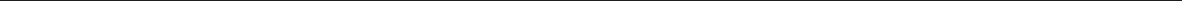
Fig. 8 Omb converts layer 1/2 into layer 3/4 T4/T5 neurons by Dac downregulation. a , b In the 3rd instar larvae ( a ), Omb (red) and Dac (blue) were initially co-expressed (arrows) in new-born R9B10-Gal4 UAS-cd8GFP (green) labeled T4/T5 neurons close to the d-IPC. In some more mature T4/T5 neurons, that were positive for Omb, Dac expression was low (arrowheads), while in others, Dac expression was high (double arrowheads) and Omb expression was absent. At 24 h after puparium formation (APF) ( b ), Dac (double arrowheads) and Omb (arrowheads) show mutually exclusive expression. c – g In controls ( c ), Dac (red, double arrowheads) was expressed in approximately 50% of T4/T5 neurons. Arrowheads indicate Dac-negative R9B10-Gal4 UAS-cd8GFP (green) labeled T4/T5 neurons. Dac was maintained in almost all T4/T5 neurons following omb knockdown ( d ), and downregulated following omb overexpression ( e ). Dac was expressed in all T4/T5 neurons in wg{KO;NRT-wg} fl ies with two lobula plate layers ( f ). Ectopic Omb was suf fi cient to downregulate Dac in these fl ies ( g ). h Quanti fi cation of all and Dac-positive T4/T5 neuron numbers following omb manipulations. The scatter plot with bars shows data points and means with ±95% con fi dence interval error bars ( n = 15 corresponding to three serial optical sections, 6- μ m apart, from fi ve samples per genotype). Unpaired, two-tailed Student ’ s t -test not assuming equal variance: P = 5.57 × 10 − 12 , P = 6.19 × 10 − 15 , P = 1.26 × 10 − 10 , P = 1.98 × 10 − 17 , P = 3.60 × 10 − 5 , P = 4.79 × 10 − 15 , P = 0.020, P = 0.017, P = 0.0015, P = 2.42 × 10 − 13 . * P < 0.05; ** P < 0.01; **** P < 0.0001. i – k Unlike in controls ( i ), R9B10-Gal4- mediated ectopic UAS-omb expression in T4/T5 neurons of wild type ( j ) or wg{KO;NRT-wg} ( k ) fl ies resulted in ectopic Connectin expression in the lobula plate (Lop). l Schematic illustrating Dac and Omb expression in adults. m Working model for spatial and temporal relay mechanisms regulating the formation and speci fi cation of layer-speci fi c T4/T5 neurons. For genotypes and sample numbers, see Supplementary Table